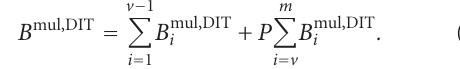
Figure 11: Number of nontrivial multiplications versus the number of remaining stages m − v for DIF radix-2 compared with DIT radix- 2 and N = 256,2048,8192.